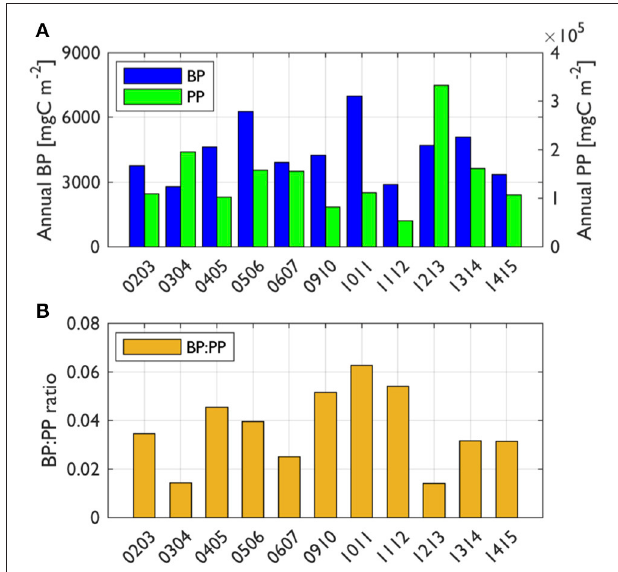
FIGURE 5 | Annually integrated BP, PP (A) and the ratio of BP to PP (B). Reduced space optimal analysis (RSOA)-interpolated values ( Figure 6 ) were annually integrated from days 290 to 440 for BP and PP for each year. Year annotations indicate the starting year of the austral growing season (i.e., 02 for October 2002 to March